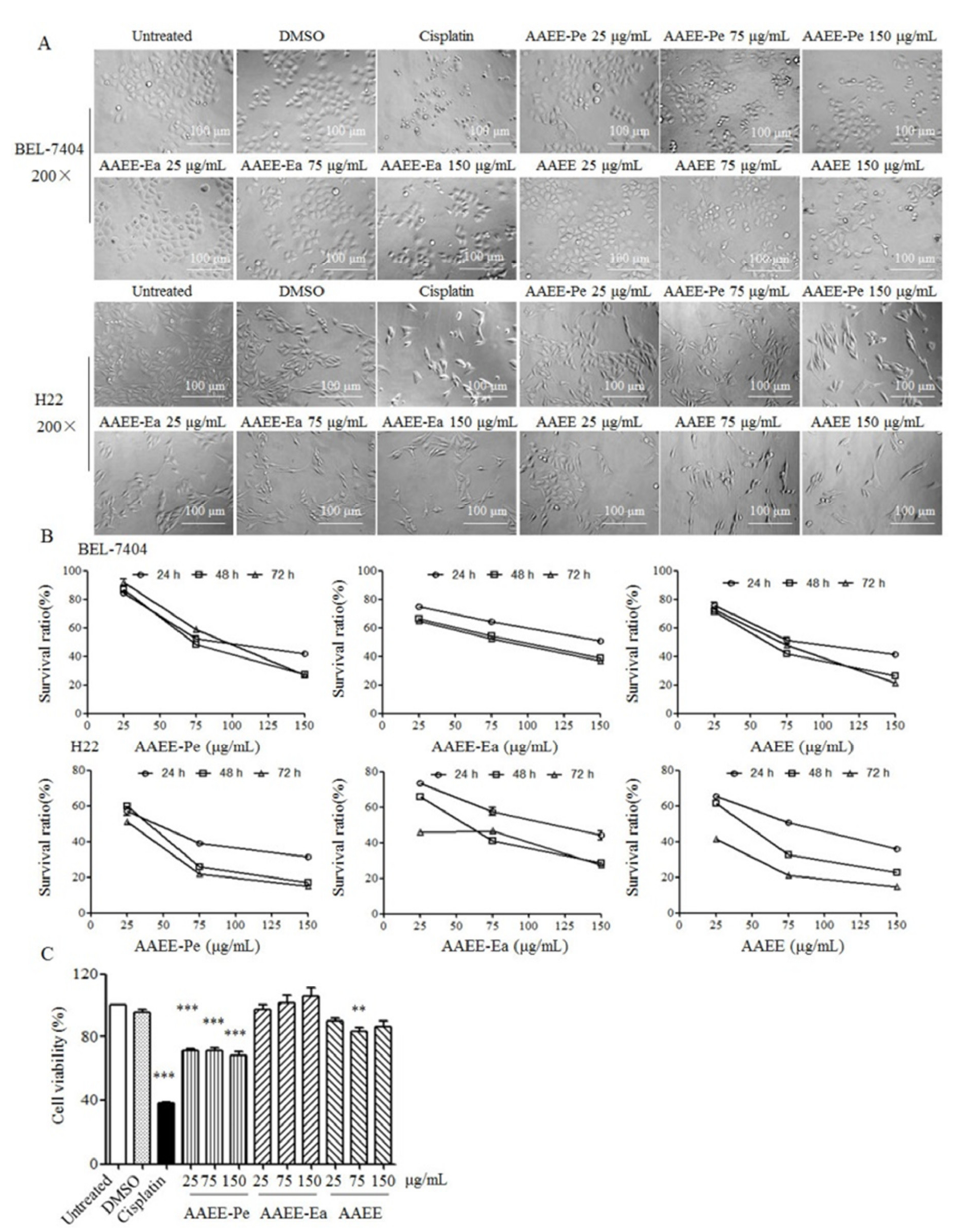
Figure 1. The effect of A. absinthium ethanol extract (AAEE) and its petroleum ether (AAEE-Pe) and ethyl acetate (AAEE-Ea) subfractions on the growth of BEL-7404, H22, and NCTC1469 cells. Cells were treated with different concentrations of AAEE, AAEE-Pe, and AAEE-Ea. ( A ) After 24 h, the morphology of BEL-7404 and H22 cells was observed by inverted microscope. ( B ) After 24, 48, and 72 h, the viability of BEL-7404 and H22 cells was detected by MTT assay. ( C ) After 24 h, the viability of NCTC1469 cells was detected by MTT assay. ** p < 0.01, *** p < 0.001 compared to